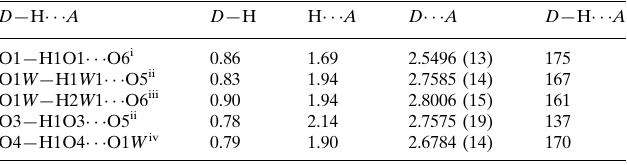
Hydrogen-bond geometry (A˚ , (cid:3)